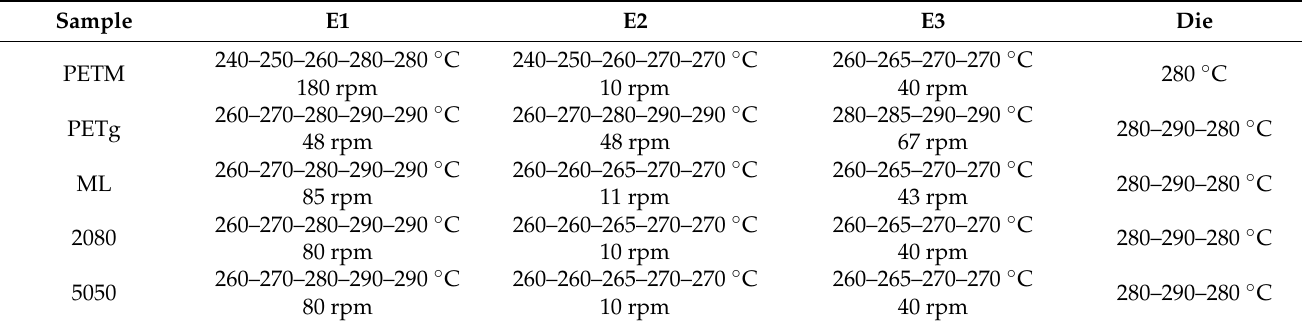
Table 2. Temperatures inside the LabTech co-extrusion unit during sheet extrusion, in which E1 (screw diameter of 30 mm) extrudes the middle layer, E2 extrudes the first outer layer (screw diameter of 30 mm) and E3 extrudes the other outer layer (screw diameter of 20